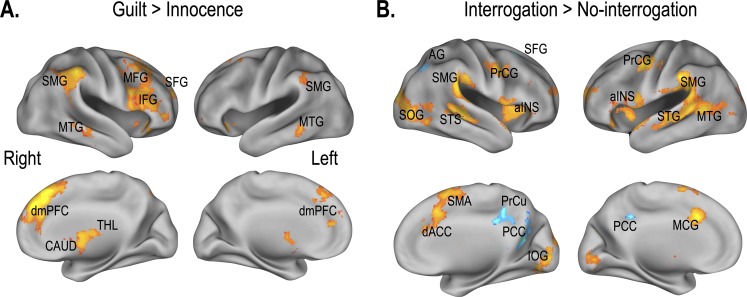
Statistical parametric maps for main effects.(A) Brain regions detected to be involved in the Guilt versus Innocence contrast are shown. (B) Brain regions detected to be involved in the Interrogation versus No-interrogation contrast are shown (red: increased activation, blue: decreased activation). IFG: inferior frontal gyrus, SFG: superior frontal gyrus, MFG: middle frontal gyrus, MTG: middle temporal gyrus, SMG: supramarginal gyrus, dmPFC: dorsal medial prefrontal cortex, CAUD: caudate, THL: thalamus, STG: superior temporal gyrus, STS: superior temporal sulcus, SOG: superior occipital gyrus, PrCG: precentral gyrus, aINS: anterior insular, IOG: inferior occipital gyrus, SMA: anterior supplementary motor area, dACC: dorsal anterior cingulate cortex, MCG: middle cingulate gyrus, AG: angular gyrus, SFG: superior frontal gyrus, PCC: posterior cingulate cortex, PrCU: precuneus.